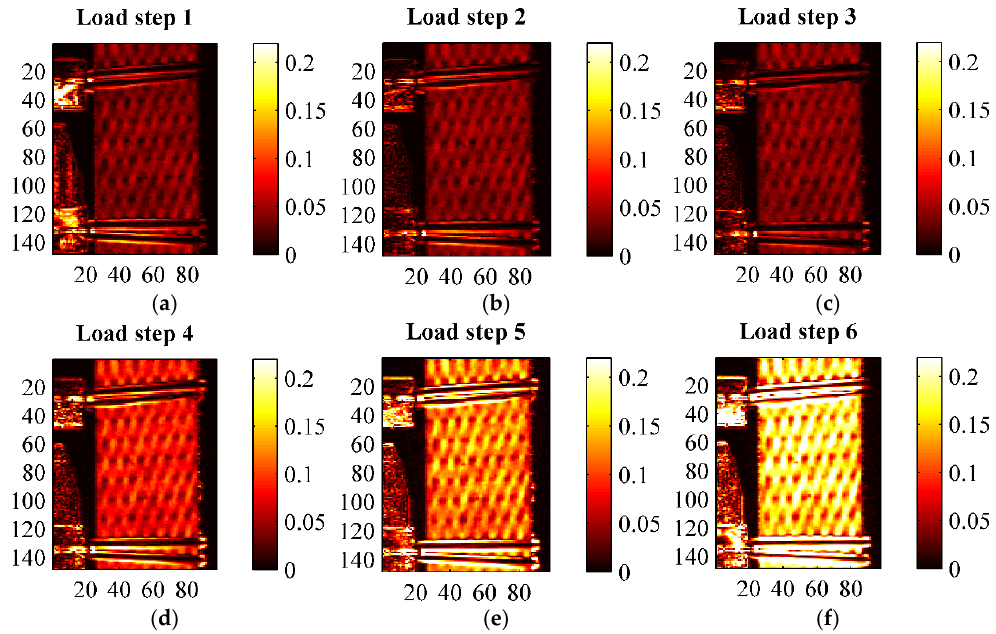
Figure 14. Thermoelastic signal amplitude Δ T in (°C) from a RI sample at the various loading steps. ( a ) load step 1; ( b ) load step 2; ( c ) load step 3; ( d ) load step 4; ( e ) load step 5; ( f ) load step 6.